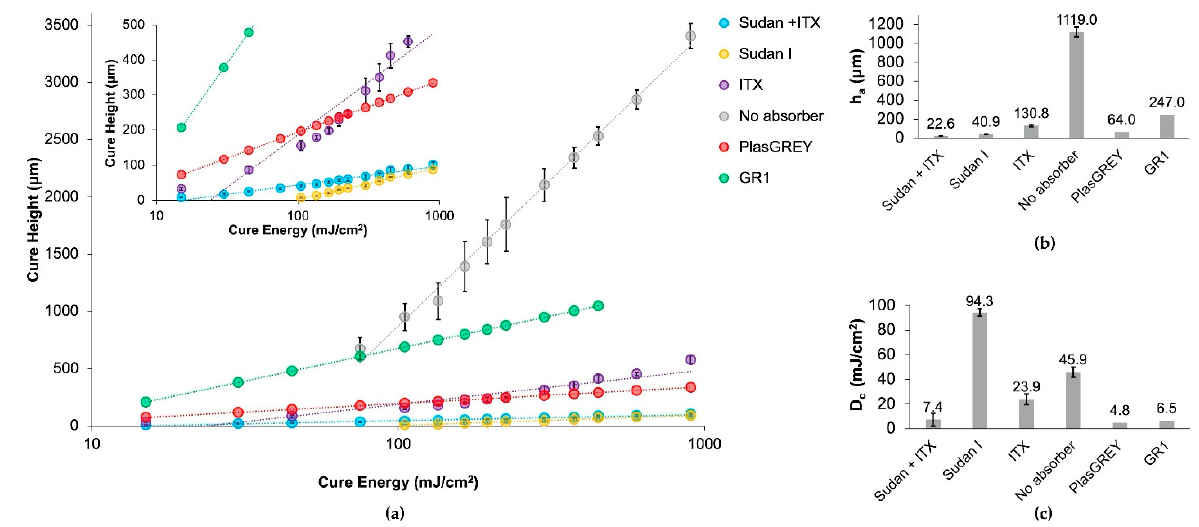
Figure 2. ( a ) Plots of cure height versus cure energy for custom resins with and without the UV absorbers, Sudan I and ITX, tested against commercial resins, GR1 and PlasGREY. The inset plot shows a zoomed-in view of the higher-resolution resins. Resin characterization data were collected at 385 nm on the Asiga MAX X UV27. Resin formulations Sudan I, ITX, Sudan I + ITX, and no absorber are all formulated with the same PDMS oligomers and same w/w % concentration of photoinitiator for comparison. Error bars represent the standard error of mean with a minimum of n ≥ 9 measurements per data point. GR1 and PlasGREY are high-resolution resins sold for use with the Asiga MAX 385 nm series. Data for these commercial resins were plotted from the corresponding material files provided upon purchasing the material, and therefore, no error bars are shown; ( b ) penetration depth values, h a , taken from the slope of each curve; ( c ) critical dose values, D c , calculated from the x-intercept of the working curve. Error bars represent standard error values from the regression fits (all fits had R 2 ≥ 0.84).